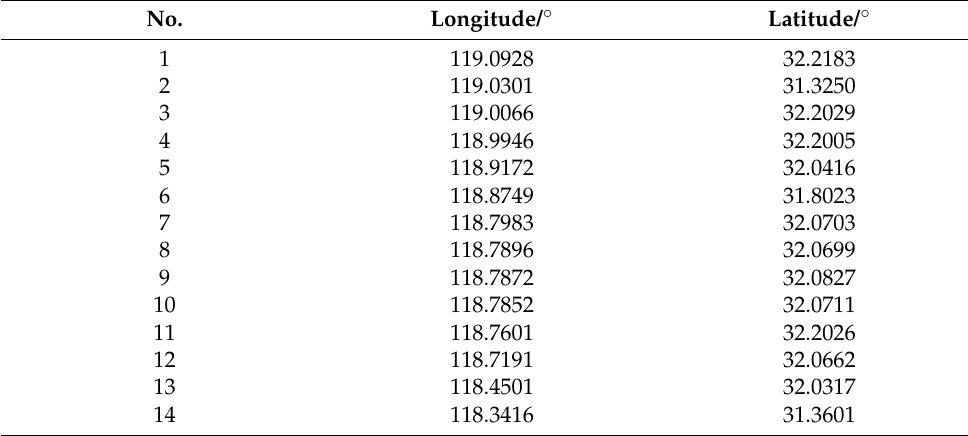
Table 4. Spot center coordinates